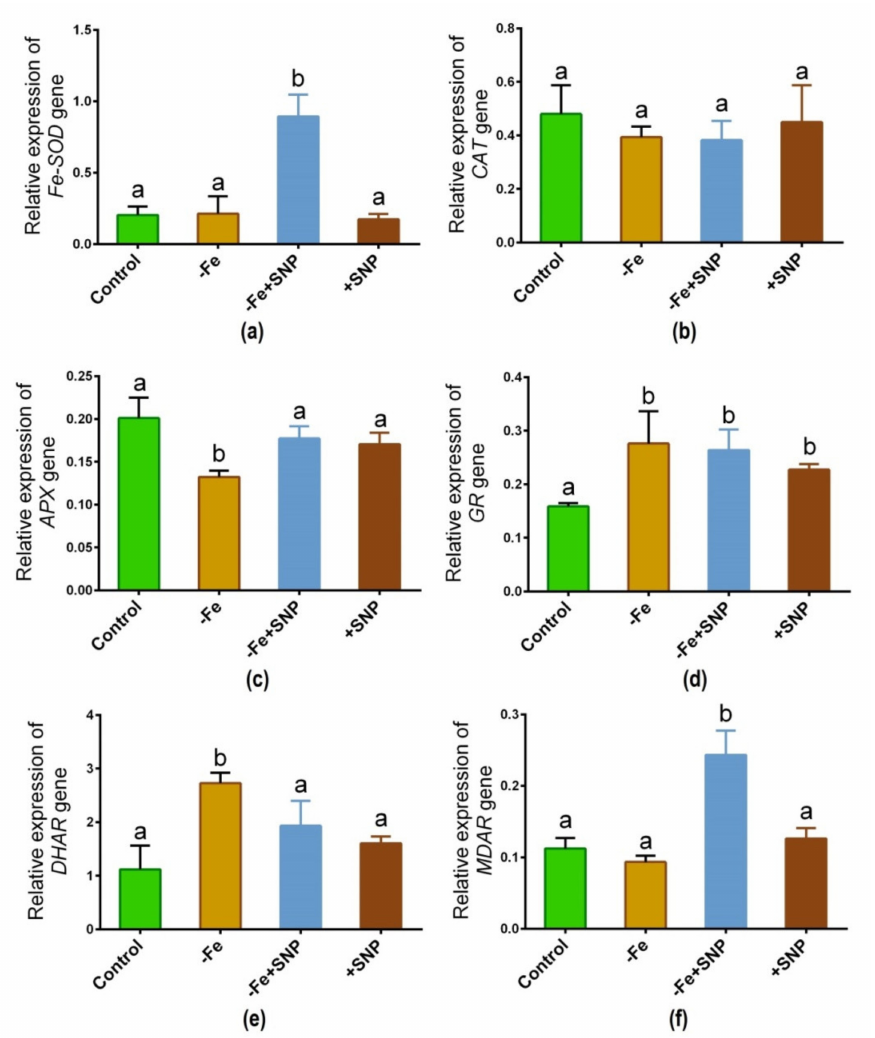
Figure 8. Fe-SOD ( a ), CAT ( b ), APX ( c ), GR ( d ), DHAR ( e ) and MDAR ( f ) candidate gene expression in alfalfa cultivated with different growth conditions: control (25 µ M FeNaEDTA); − Fe (0.1 µ M FeNaEDTA); − Fe (0.1 µ M FeNaEDTA) and sodium nitroprusside (SNP, 100 µ M) as nitric oxide (NO) donor; and SNP (100 µ M). Different letters above the error bar indicate significant differences ( p < 0.05) among means ± SD of treatments ( n =